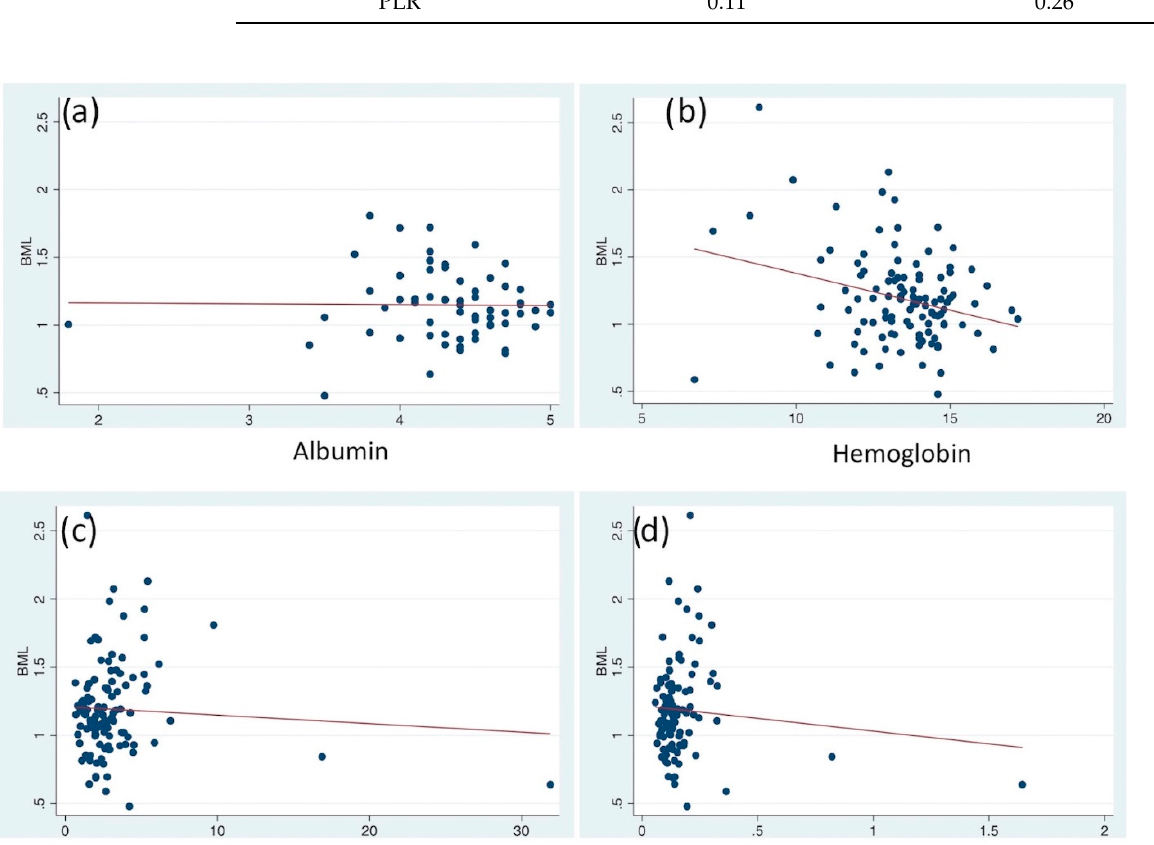
Figure 3. Correlation analysis. Bone marrow-to-liver SUV (BML) was compared with serum albu- min ( a ), hemoglobin level ( b ), neutrophil-to-lymphocyte ratio (NLR) ( c ), and platelet-to-lymphocyte ratio (PLR) ( d ). Table 2. Correlation analysis of the bone marrow-to-liver SUV ratio (BML) with serum laboratory tests. NLR: neutrophil-to-lymphocyte ratio; PLR: platelet-to-lymphocyte